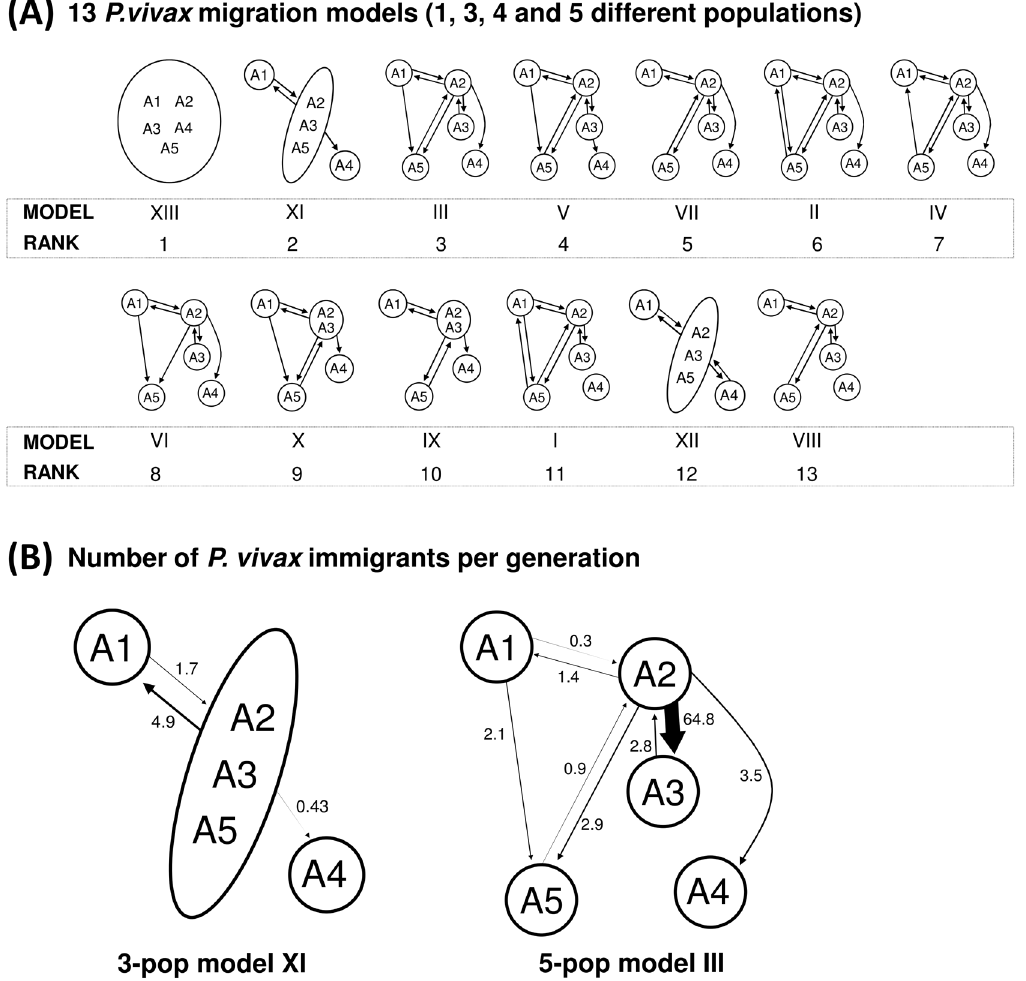
Fig 7. Comparison of 13 parasite migration models and summary estimates of gene flow. ( A ) The study areas were pooled as an unique population and in 3 – 5 populations. The arrows represent the direction of migration and the models are displayed by its rank order. The marginal log-likelihoods and LBF used to rank the models are tabulated in S4 Table. The model XIII (panmixia) has the highest model probability ( > 0.99) while all the rest have near zero probability. ( B ) The estimated number of immigrants per generation are described for the models XI and III. The thicknesses of the arrows are proportional to the number of immigrants. The Θ and M estimates for the models XIII, XI and III are tabulated in S5